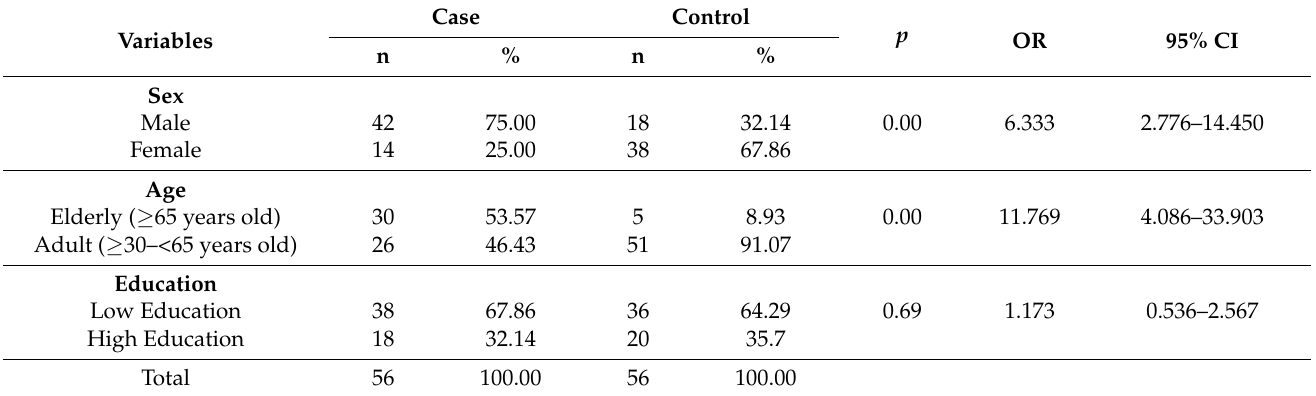
Table 1. Characteristics of